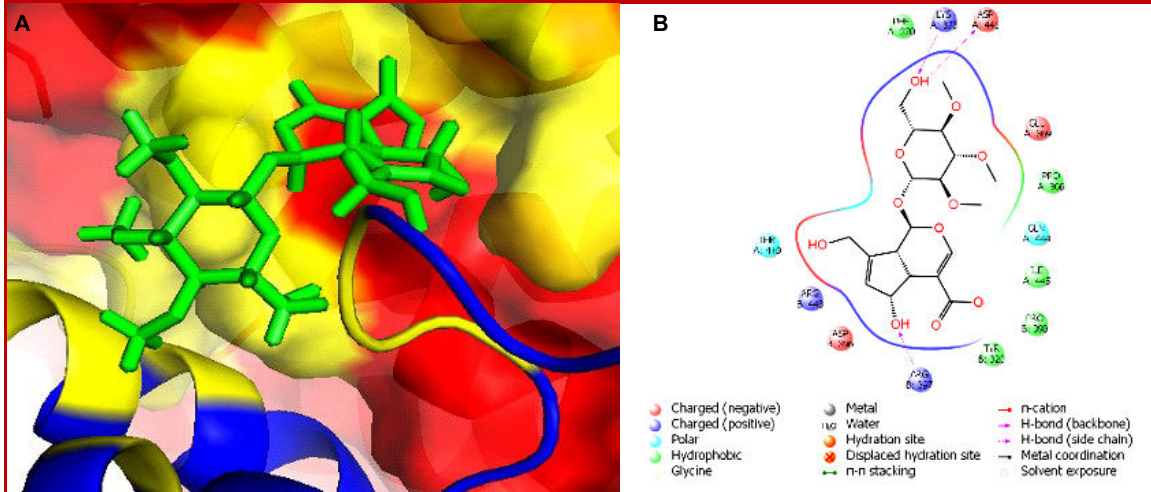
Figure 3: Probable interaction of C1 with PPAR γ predicted using molecular docking studies. A: surface view; B: ligand interaction diagram A